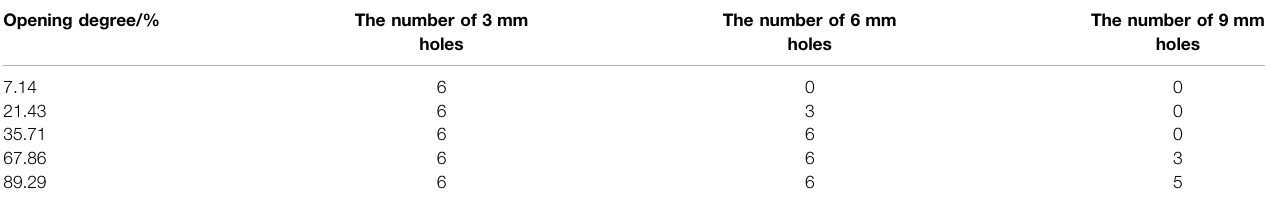
TABLE 1 | The number of opened throttling holes with their different opening